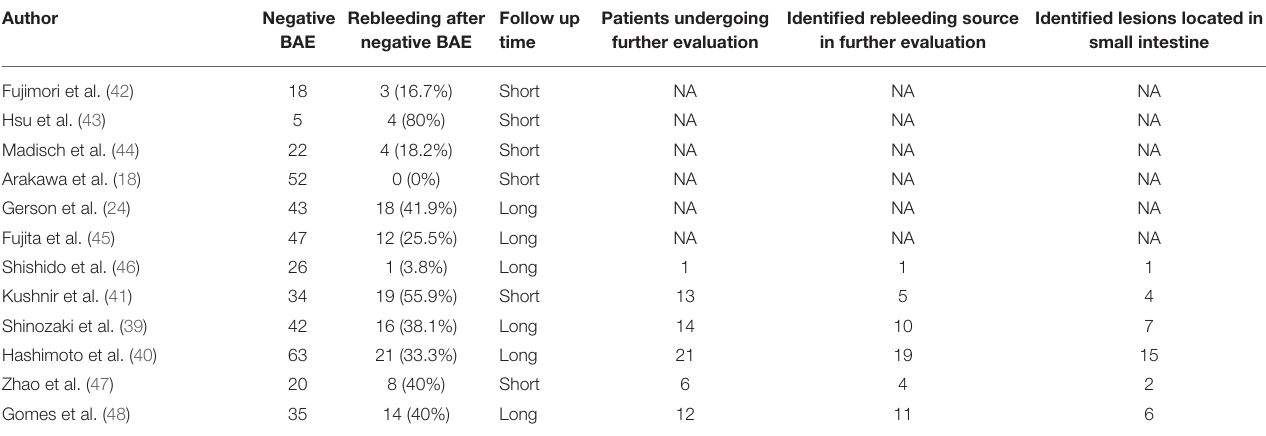
TABLE 2 | Outcomes of the individual